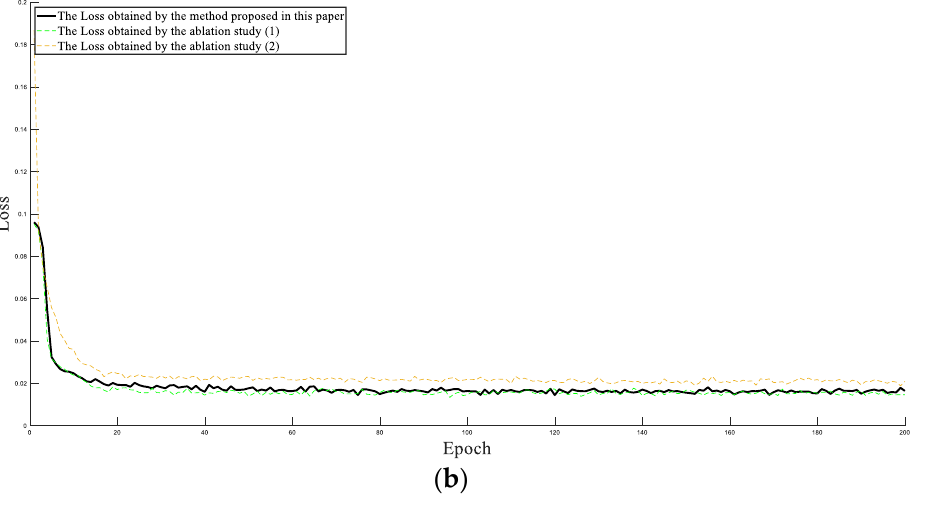
Figure 12. Comparison of ablation study. ( a ) The HI of training bearing 1_1 under three test condi- tions, ( b ) the loss of training bearing 1_1 under three test conditions.